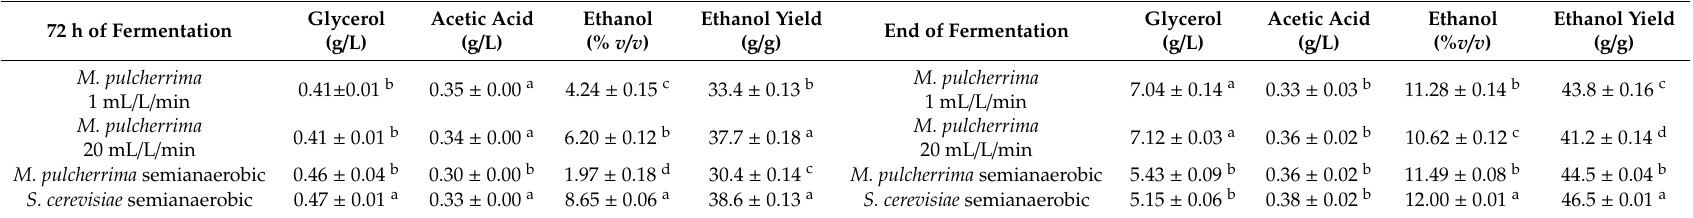
Table 2. Main analytical characters of sequential fermentation with M. pulcherrima in di ff erent fermentation conditions semianaerobic, 1 mL / L / min and 20 mL / L / min at 72 h and at the end of